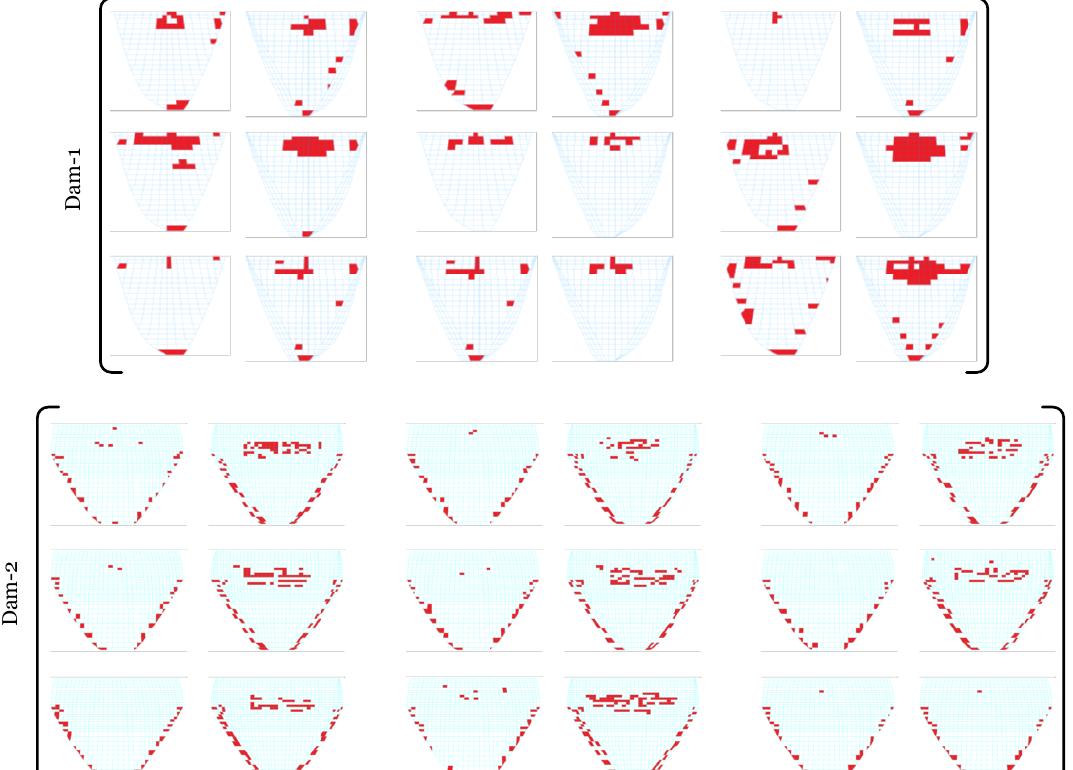
Figure 7. Crack profile of both dams from nonlinear analysis subjected to seismic intensity level-3 (SIL-3) ground